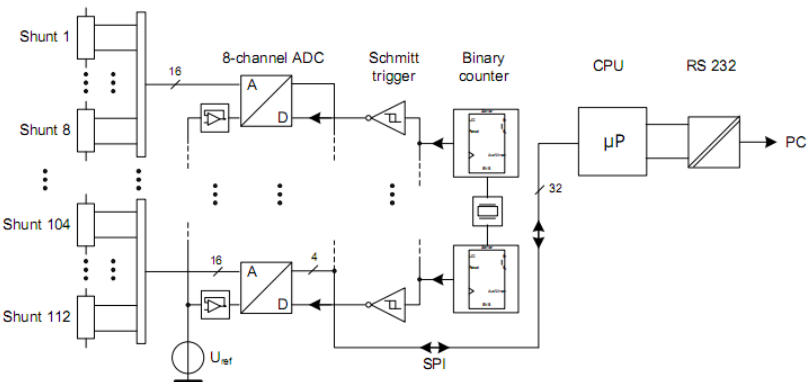
Figure 5. Schematic of the developed electronics